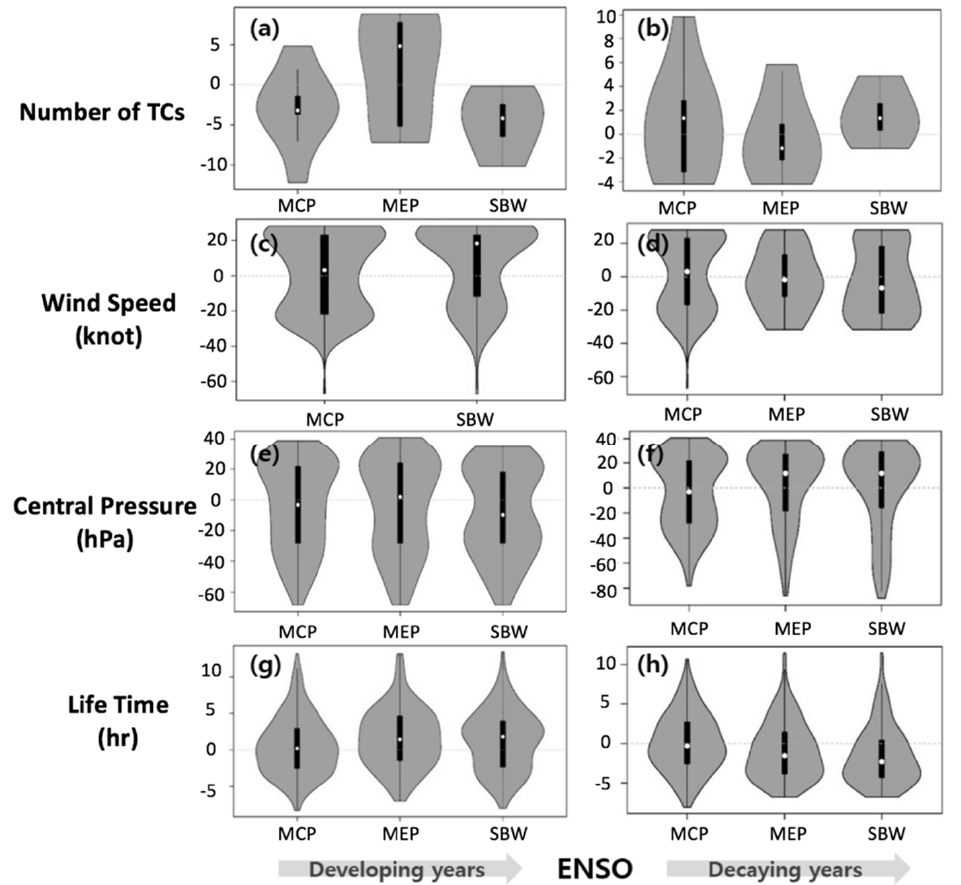
Figure 2. Violin plots of tropical cyclone (TC) activities and their probability during different types of El Niño–Southern Oscillation (ENSO) events. ( a , b ) show the annual number of TCs, ( c , d ) indicate wind speed anomaly patterns of TCs, ( e , f ) show the central pressure anomaly, and ( g , h ) indicate lifetime anomalies during developing and decaying years. For each panel, the violin plot shows the kernel probability density of the data, including a dot to mark the median and a thick line to indicate the interquartile range of each dataset. MCP: moderate central Pacific, MEP: moderate eastern Pacific, SBW: strong basin-wide.